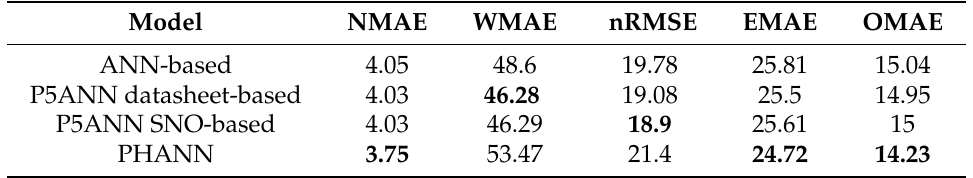
Table 4. Numerical comparison between the four ANN-based models according to average error values.